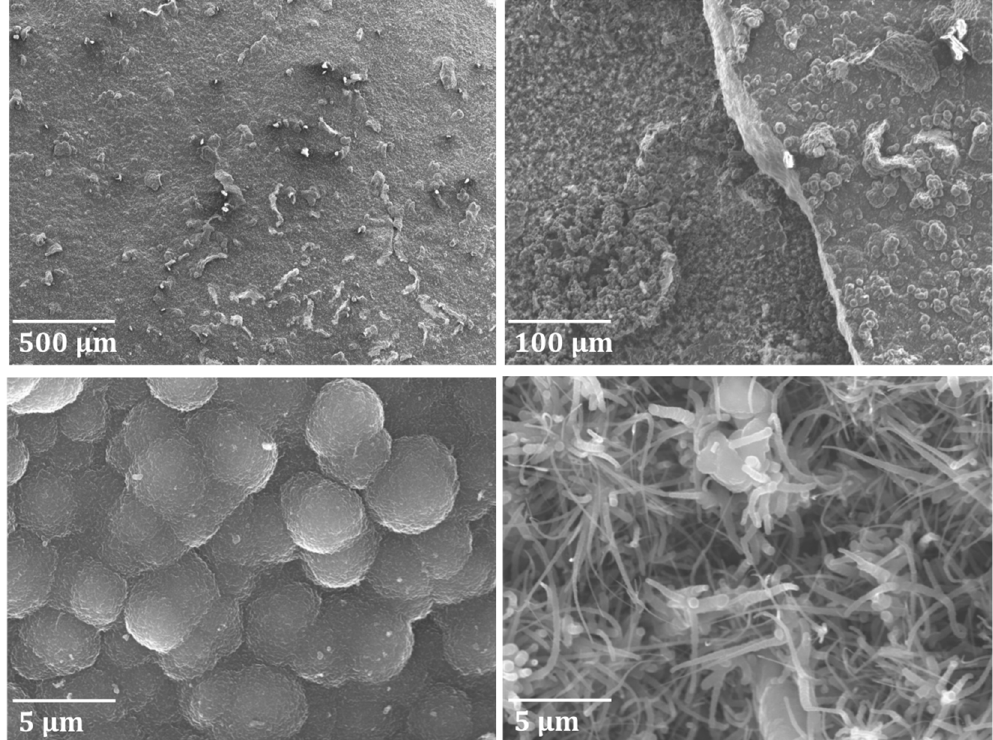
Figure 8. Surface of a coked Ti–base alloy coupon after pretreatment B and seven coking/decoking cycles followed by a 6 h coking. The figure on the top left shows the surface at a magnification of 50×, while the figure on the top right shows the area of breakage at a magnification of 100×. Both images at the top are recorded at an accelerating voltage of 10 kV. The image on the bottom left displays the regular surface area, while the image on the bottom right shows the area where breakage of the coupon occurred. Both images at the bottom are recorded at an accelerating voltage of 20 kV.